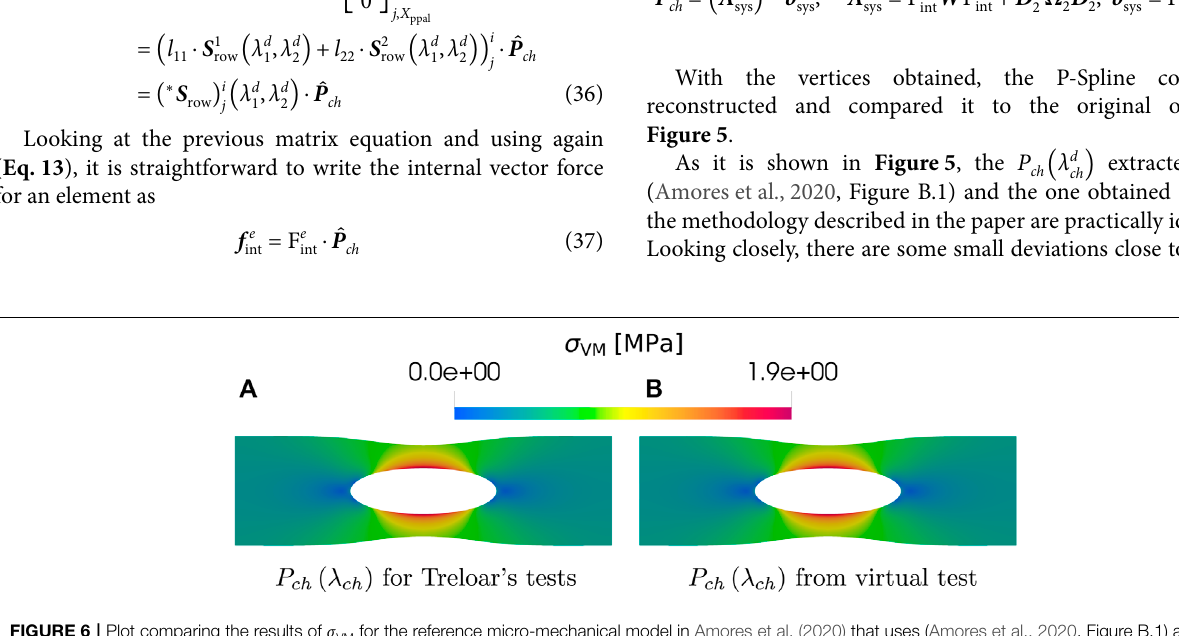
Frontiers in Materials |